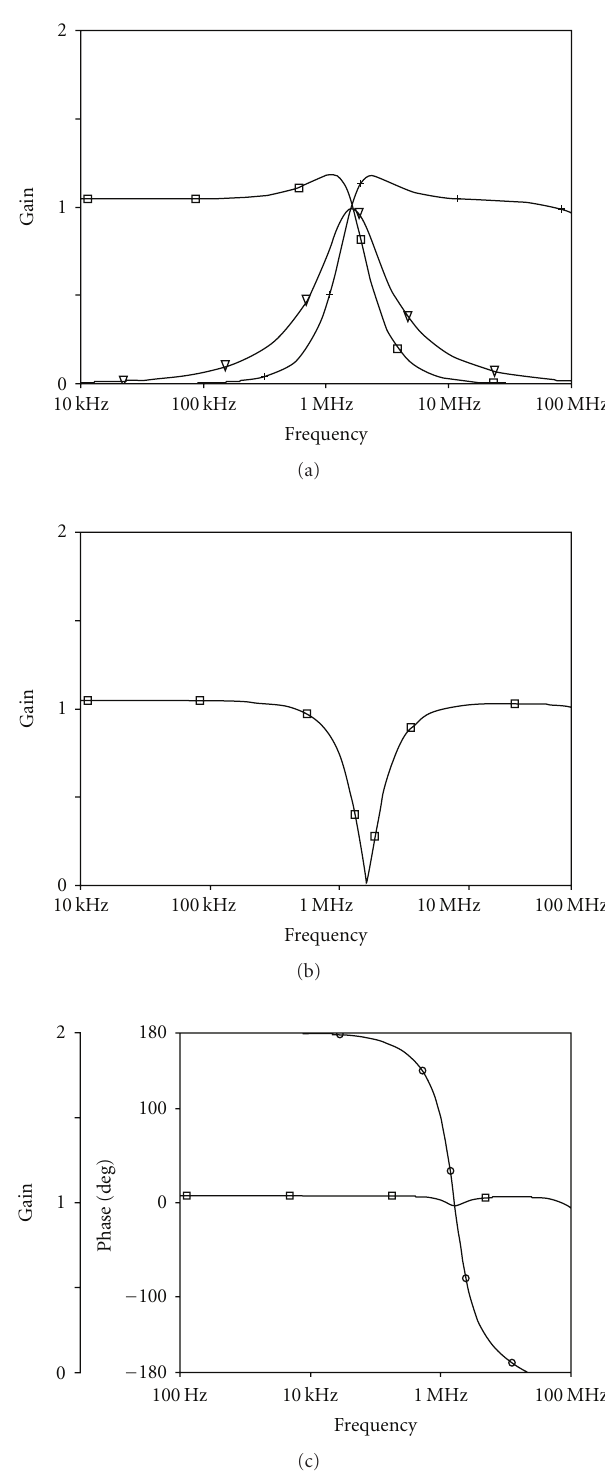
Figure 6: Simulated response of the proposed current mode universal filter: (a) high-pass, low-pass and band-pass, (b) notch, (c) all